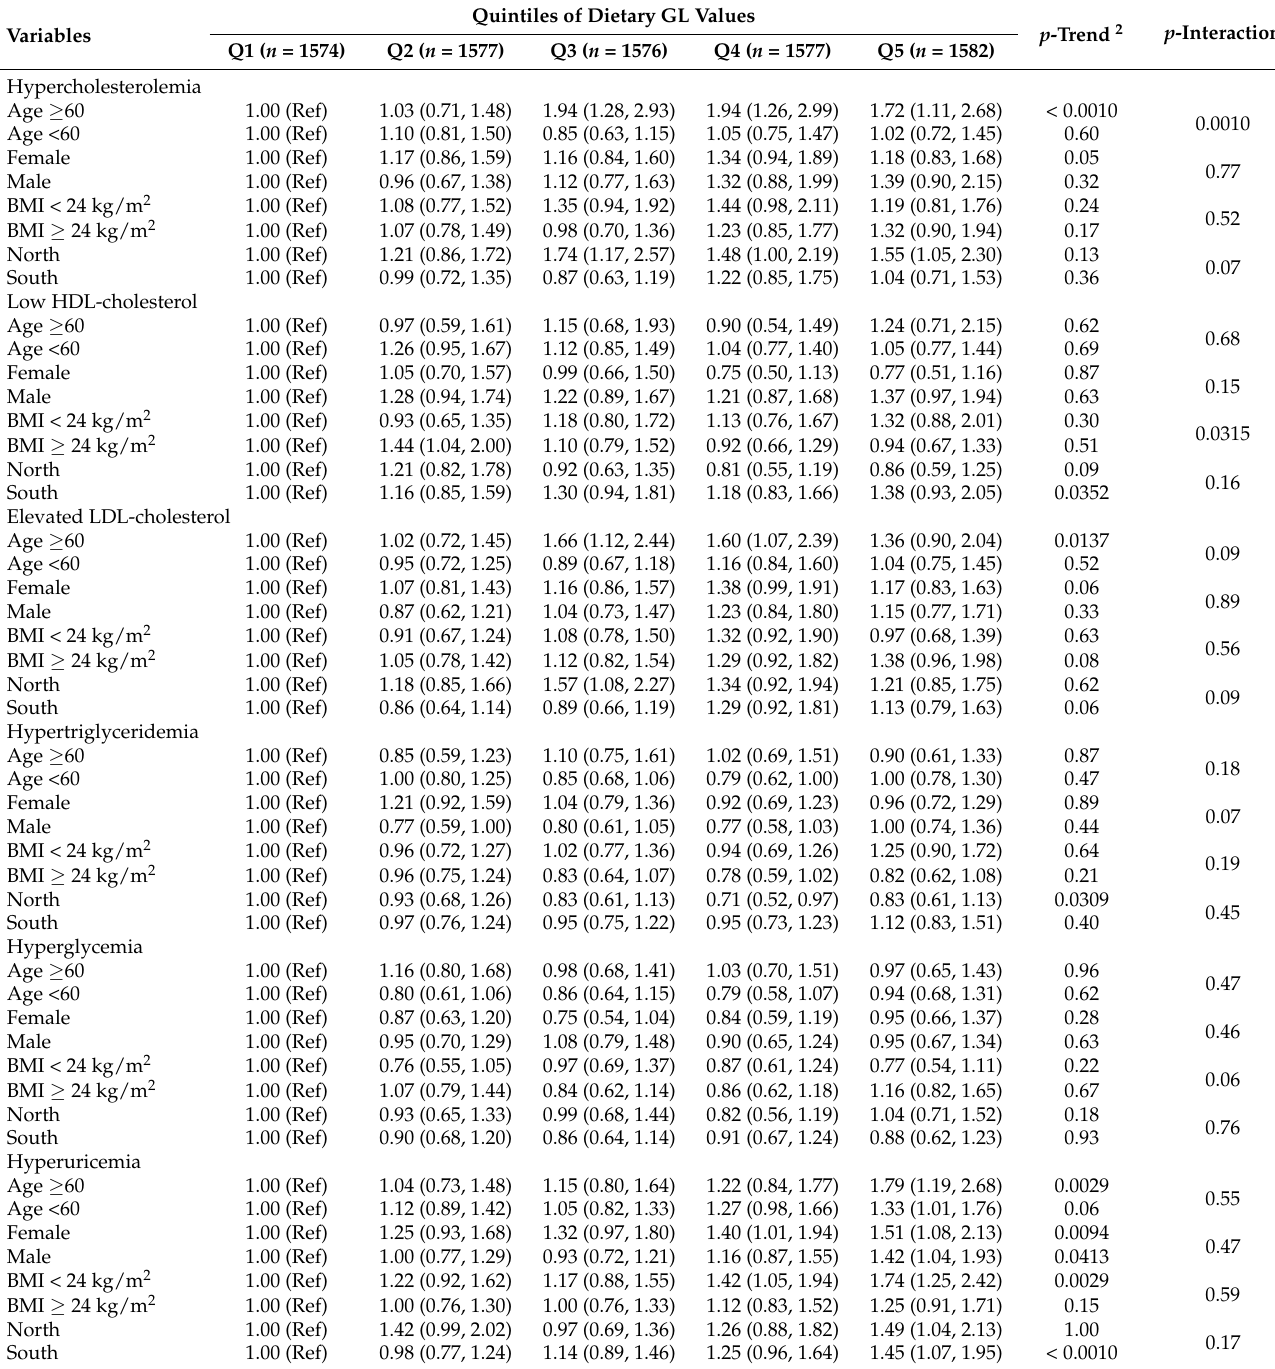
Table 5. The associations between quintiles of dietary GL values and cardiometabolic risk factors of 7886 Chinese adults who participated in the China Health and Nutrition Survey 2009, stratified by age, sex, BMI, and region ( N = 7886) 1